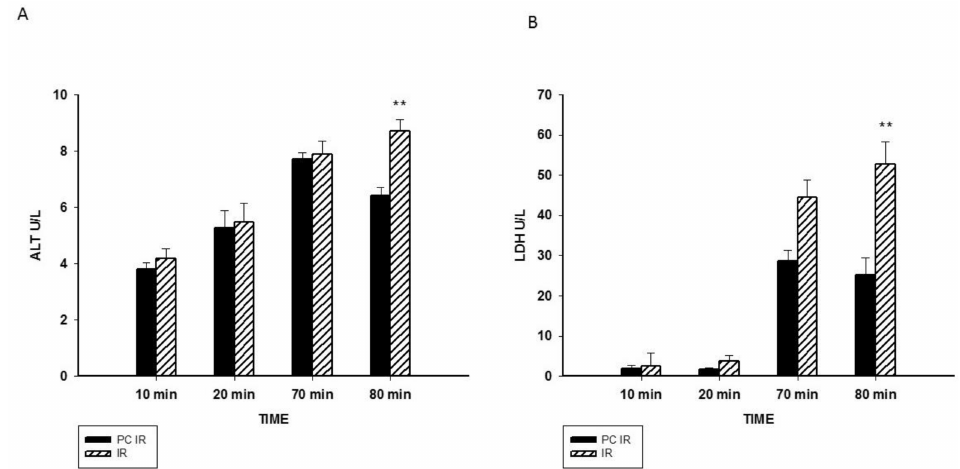
Figure 2. Effect of hypothermic perfusion on cellular integrity. ( A ) Alanine aminotransferase (ALT) in the perfusate; and ( B ) lactate dehydrogenase (LDH) in the perfusate. Data is mean ± SEM of six animals. Significantly different from corresponding PC IR values by Student’s t test: ** p < 0.01.